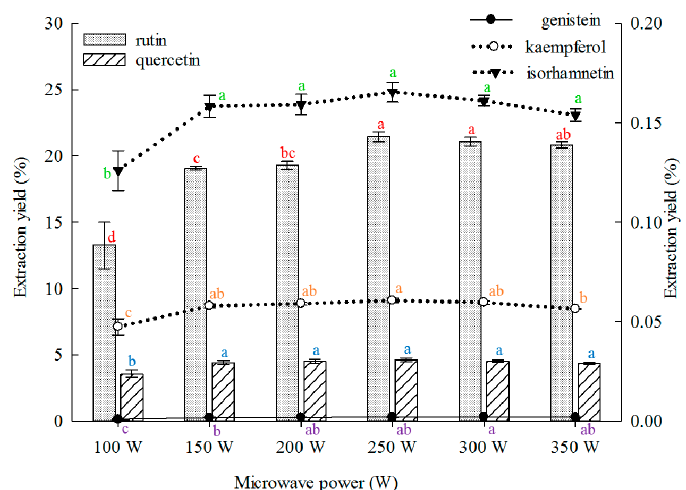
Figure 5. Effect of microwave power on the extraction yields of the five constituents (the bar and lines graphs are referenced to the left and right axes, respectively; different letters stand for significant difference at 5% level).